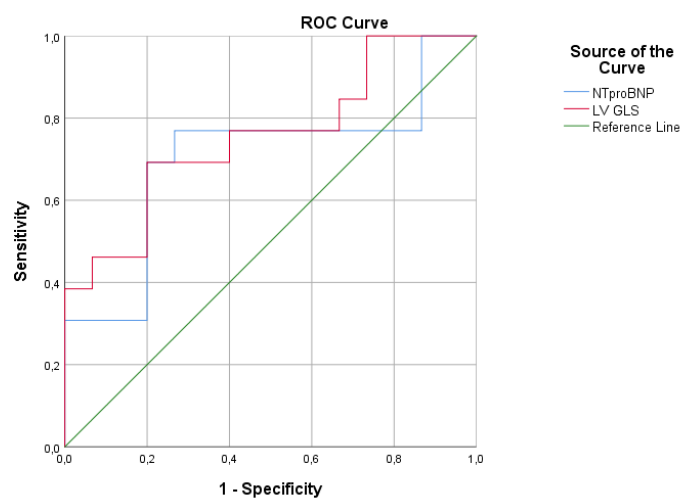
Figure 3. In ROC curve analysis, a cut-off value for NTproBNP of 145.25 pg/mL predicted LGE RV score > 8 points with specificity 80% and sensitivity 73.3% [AUC 0.729 ( p = 0.03)], and a cut-off value for LV GLS of − 15.9% predicted LGE RV score > 8 points with specificity 80% and sensitivity 69.2% [AUC 0.754 ( p = 0.02)].